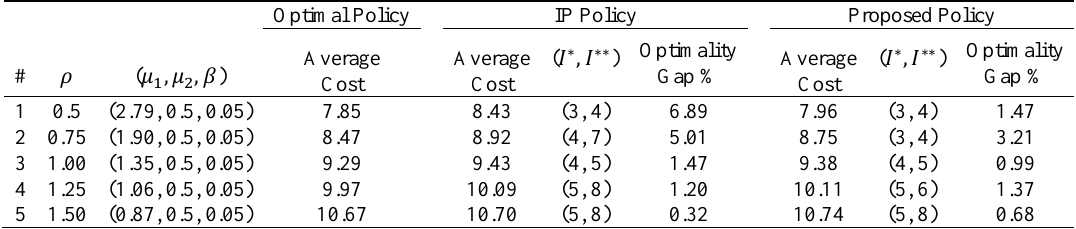
Table 8. Performances of the Alternative Policies with DFR distribution, s=5 and K=0 Optimal Policy IP Policy Proposed Policy